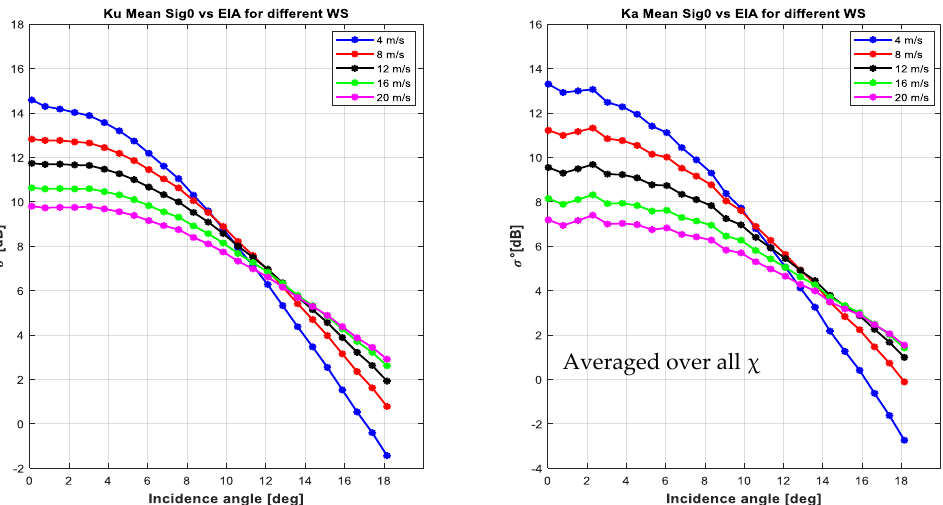
Figure 9. Mean value of binned σ 0 (in dB) at KuPR ( left ) and KaPR ( right ) as a function of earth incidence angle θ , for different wind speeds.